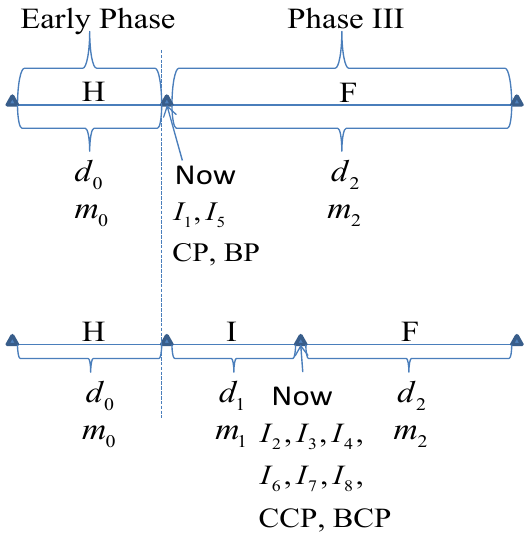
Figure 1. The four powers, the eight predictive powers, and the data structures of the historical data, interim data, and future